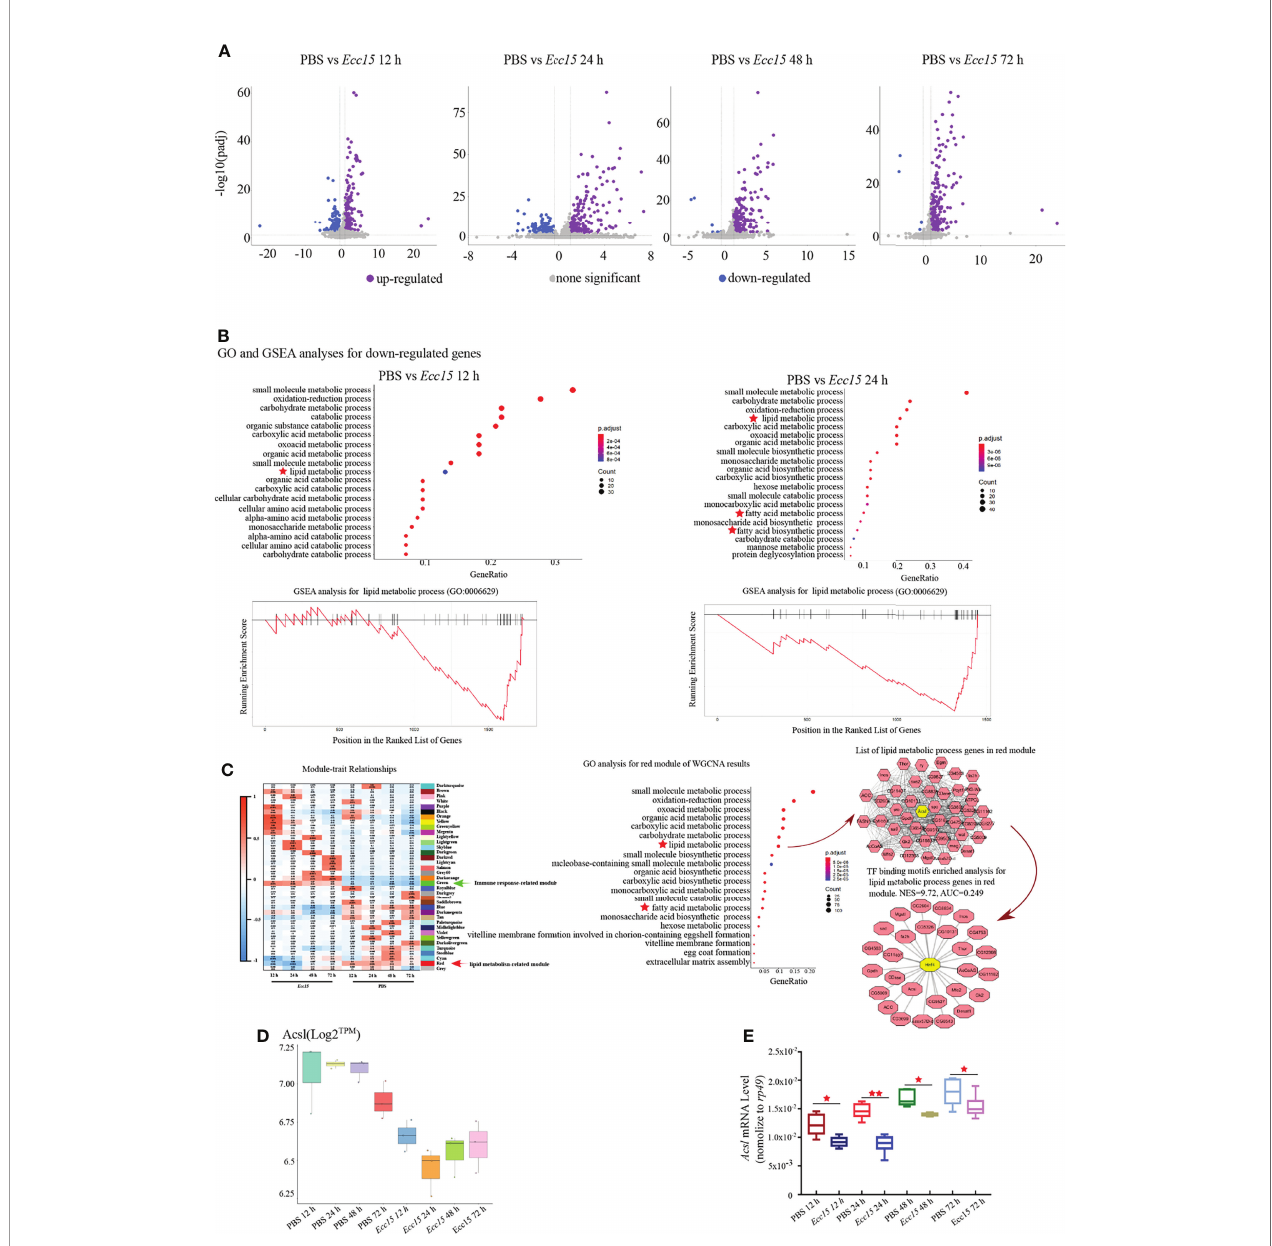
FIGURE 3 | Time-course transcriptomic analysis reveals that changes of lipid metabolism related gene expression pro fi les occur in response to Ecc15 infection. (A) . Volcano plot of differentially expressed genes (DEGs) with >2-fold up- or >0.7-fold down-regulation changes (p-adj<0.001) in fl ies infected with Ecc15 at indicated time points (12, 24, 48, 72 hpi), compared with control fl ies. (B) . GO analysis (upper panel) for the down-regulated genes in (A) and GSEA analysis (lower panel) for genes with GO termed “ lipid metabolic process ” (GO:0006629) in down-regulated genes at indicated time points (12, 24 hpi). (C) . Left panel, WGCNA analysis for time-course transcriptomic data. Middle panel, GO analysis for Module Red of WGCNA result. Right panel, hub-gene analysis (right-upper) and TF binding motifs enrichment analysis (right-lower) for genes with GO termed “ lipid metabolic process ” (GO:0006629) in Module Red. (D, E) . Transcripts per million (TPM) (D) and Q- PCR (E) plot of Acsl mRNA level in control (PBS) and Ecc15 -challenged ( Ecc15 ) fl ies at indicated time points (12, 24, 48, 72 hpi). *, p < 0.05; **, p < 0.001. (One- way ANOVA test with a Sidak